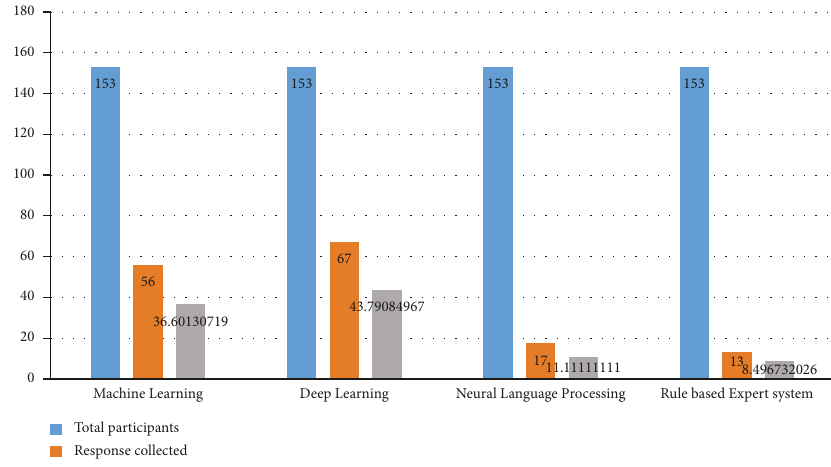
Figure 4: Graphical representations of effective AI-based